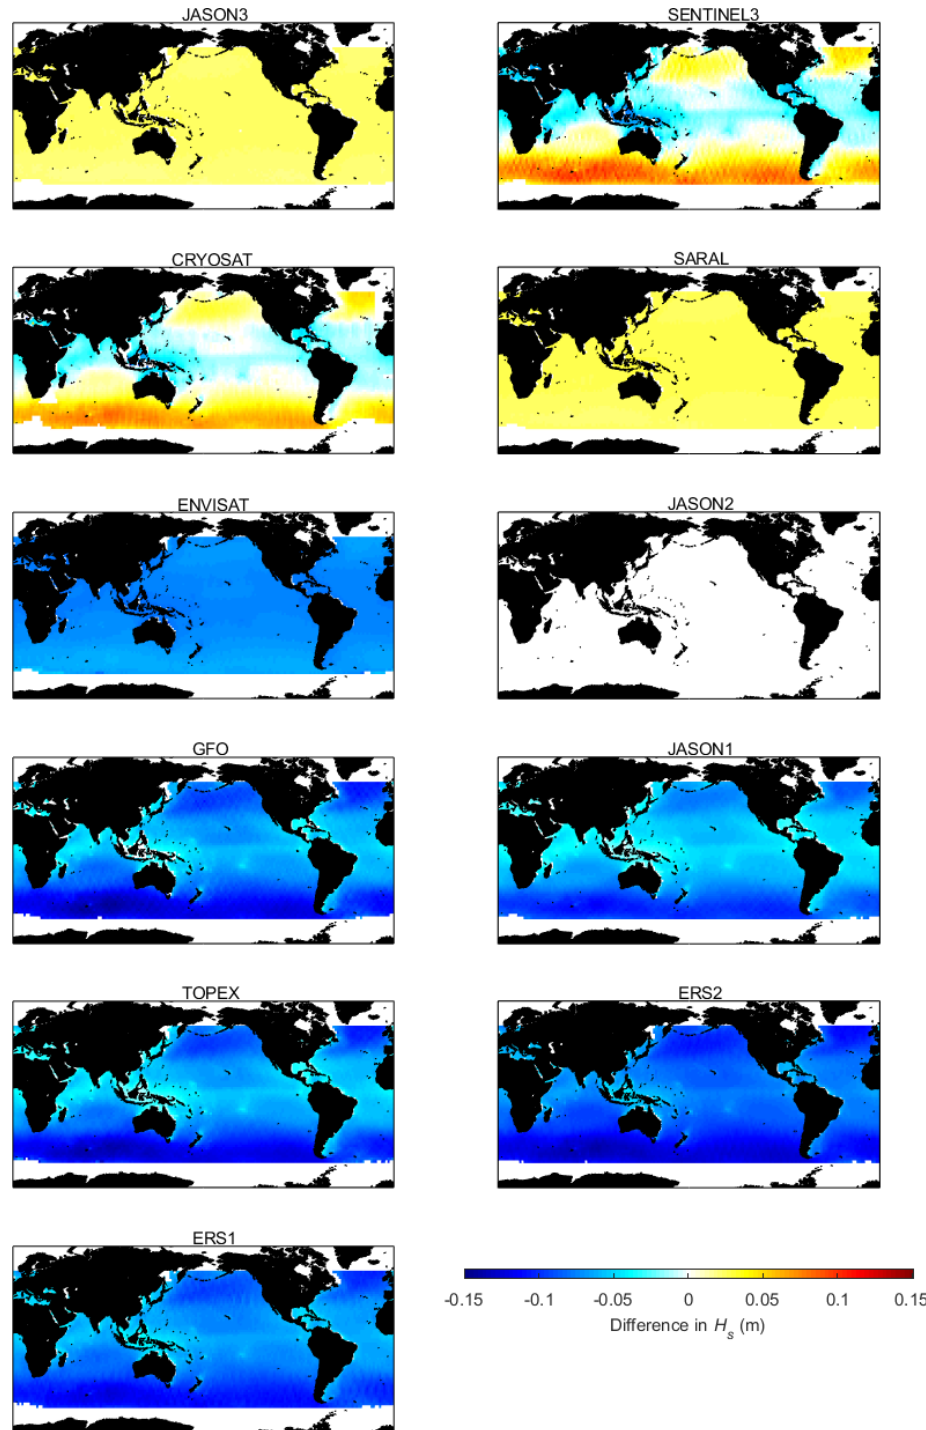
Figure 5. Differences between mean significant wave height averaged over each altimeter mission for different calibration approaches ∆ H s = H alt buoy alt s , where H s and H s are values of H s for the “altimeter–buoy” and “altimeter–altimeter” calibrations, respectively. Units shown in color bar (m). Order of altimeter mission launch dates is from the bottom to top and left to right: ERS1, TOPEX, ERS2, GFO, etc.